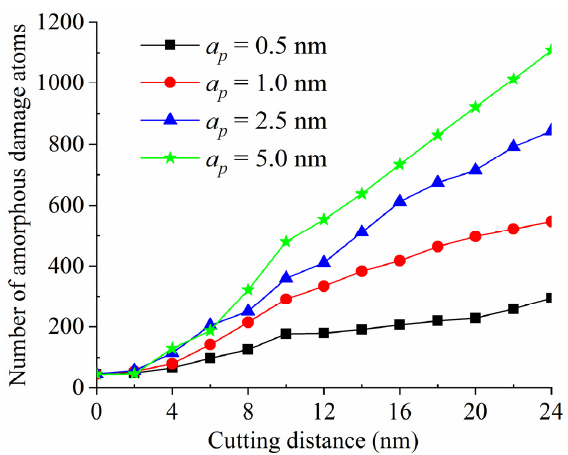
Figure 12. The variations of number of amorphous damage atoms with different undeformed cutting